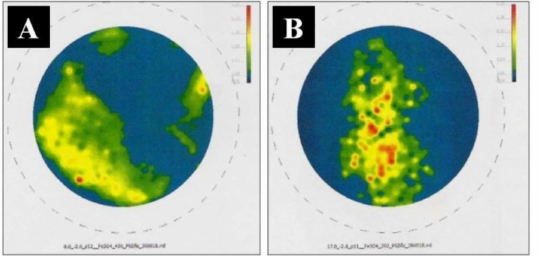
Figure 6. Corrected, incomplete polar figure obtained for the Fe 3 O 4 phase, for [Polylactide (PLA)